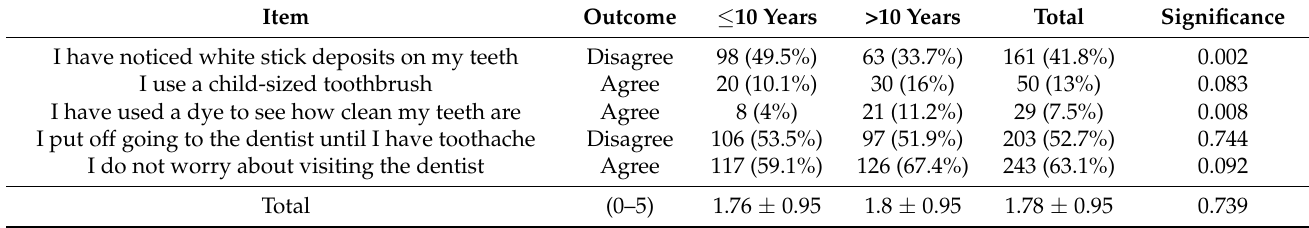
Table 3. Oral health-related behaviours of elementary schoolteachers stratified by work